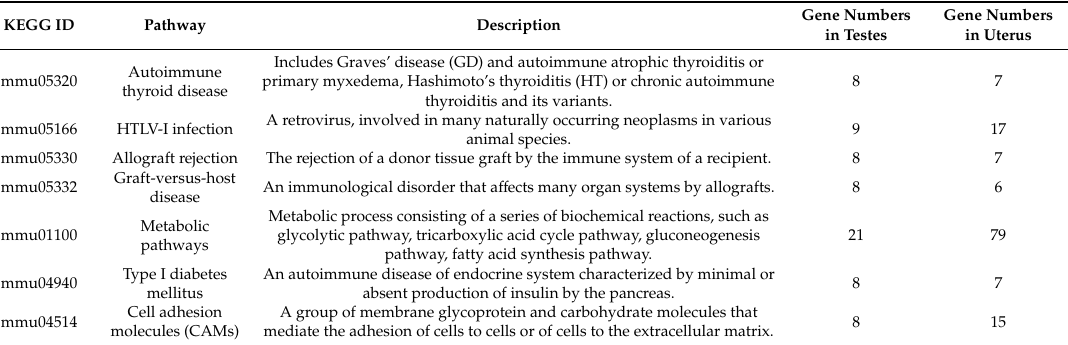
Table 3. Common pathway in the testes and uterus of infected mice.